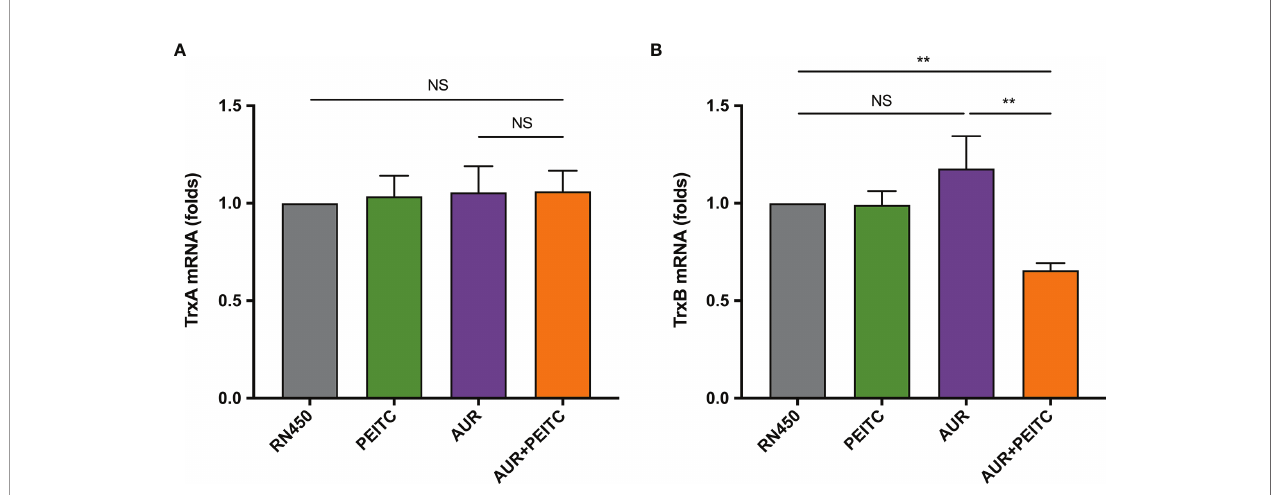
FIGURE 4 | Fold changes in trx B expression in the combination of AUR and PEITC. Expression of (A) trx A and (B) trx B genes in S. aureus RN450. RN450 were untreated or treated with 8× MIC aurano fi n (AUR), 1× MIC phenethyl isothiocyanate (PEITC), or in combination for 96 h. **P < 0.01; NS, no signi fi cance. Data are from at least three independent experiments; error bars indicate standard errors of the